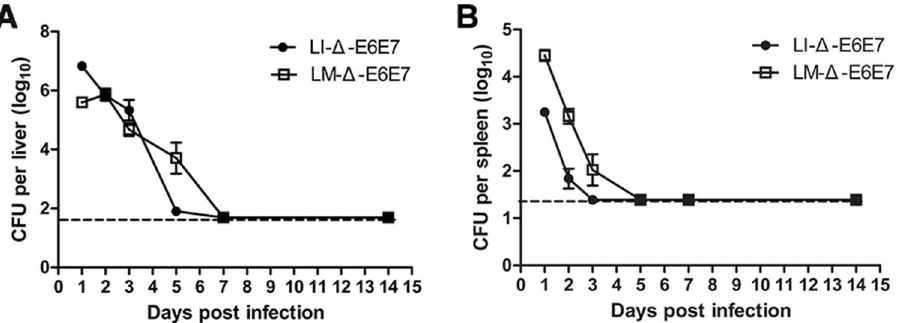
Figure 3. Bacterial load in the liver and spleen after intravenous immunization. Mice were intravenous injected with 1.3 × 10 7 CFUs LMΔ-E6E7 or 4 × 10 7 CFUs LIΔ-E6E7, and the bacterial load in the liver ( A ) and spleen ( B ) were determined on 1, 2, 3, 5, 7, 14 dpi. Results present as mean ± SEM per group of five mice from three independent experiments. The dashed line represents the detection limit in each experiment. Experiments were performed in